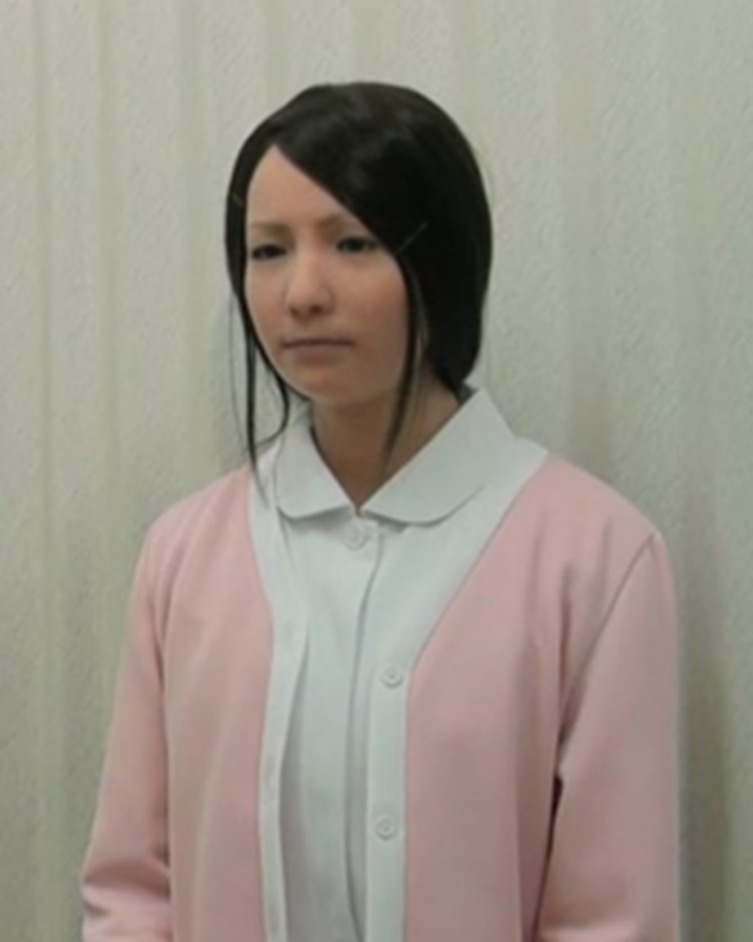
Actroid-F (android).